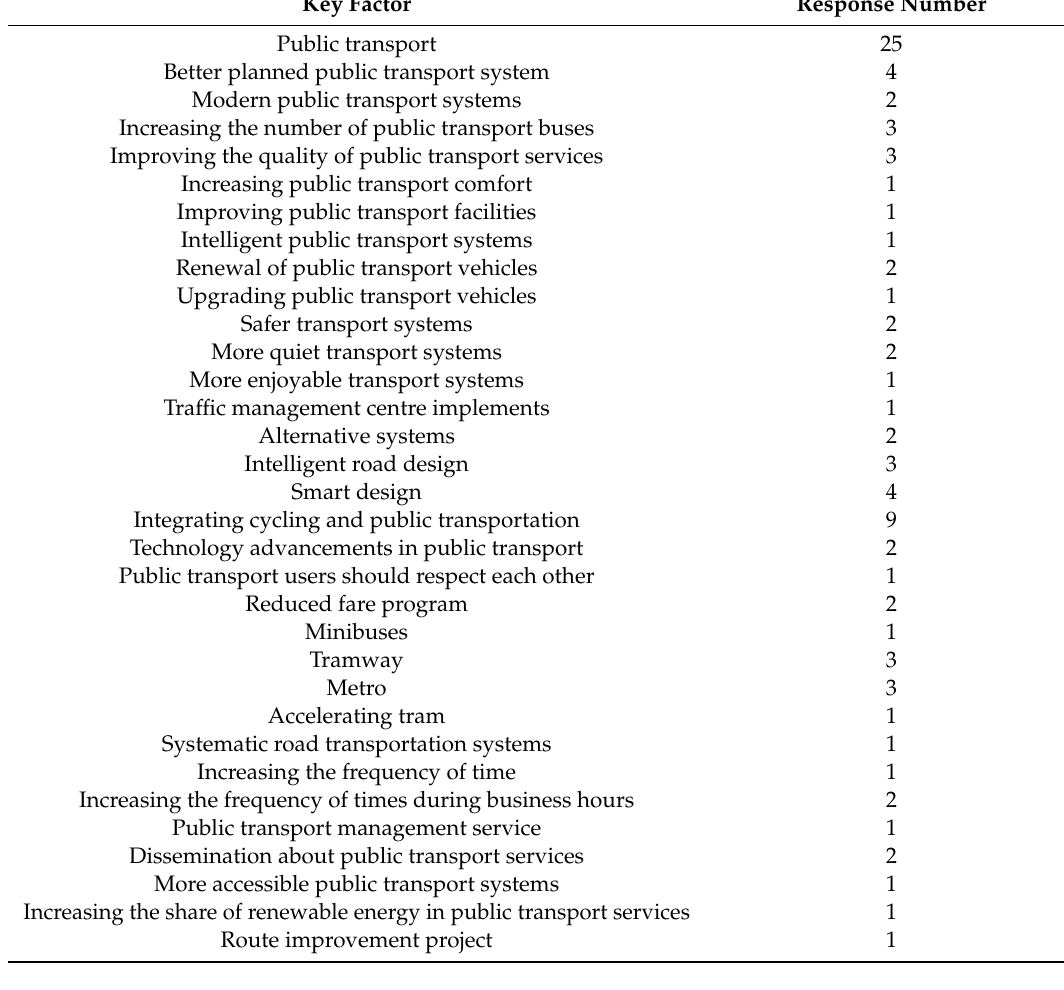
Table A2. Public transport systems.